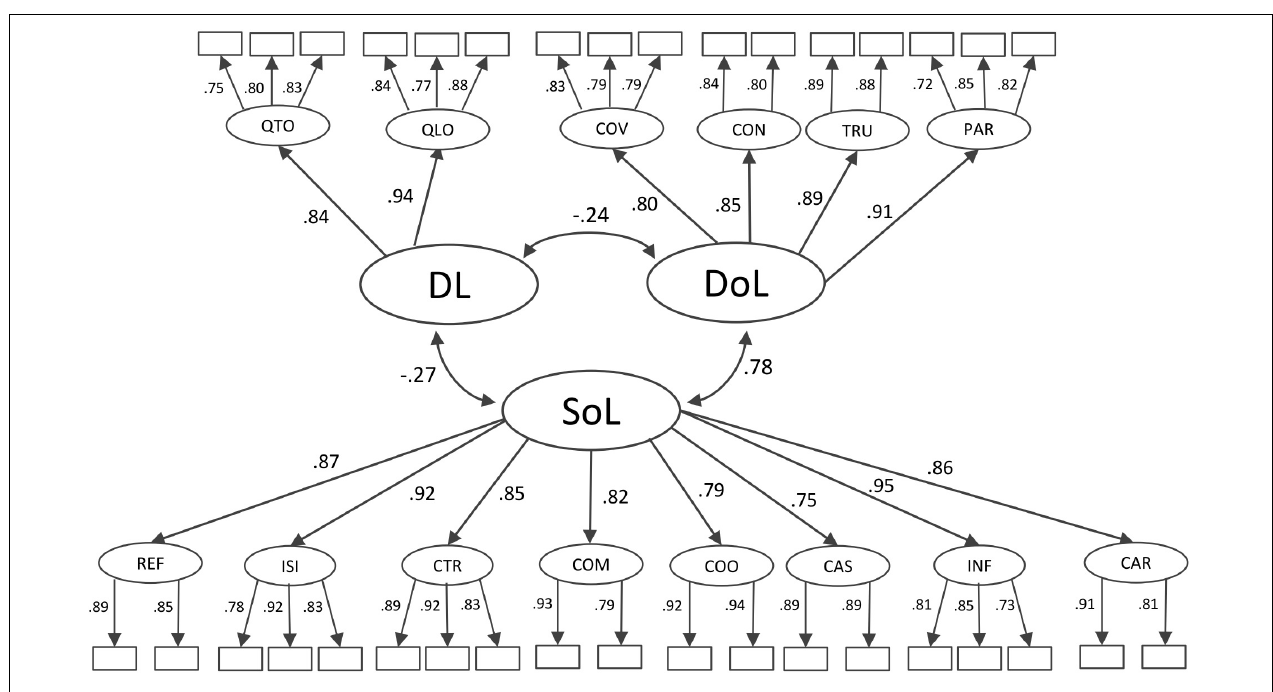
FIGURE 2 | Standardized coefficients of the second-order confirmatory factor structure (Model 3). DL = Demanding Leadership, DoL = Development-oriented Leadership, SoL = Support-oriented Leadership. QTO = Quantitative Overload, QLO = Qualitative Overload, COV = Complexity/Variability, CON = Control, TRU = Trust, PAR = Participation, REF = Recognition/Feedback, ISI = Instrumental Support/Information, CTR = Clarity/Transparency, COM = Conflict Management, COO = Cooperation, CAS = Career Support, INF = Integrity/Fairness, CAR = Care. Items are displayed as rectangles. TABLE 5 | Model fit indices for the two second-order models to test measurement invariance across the three samples. Model χ 2